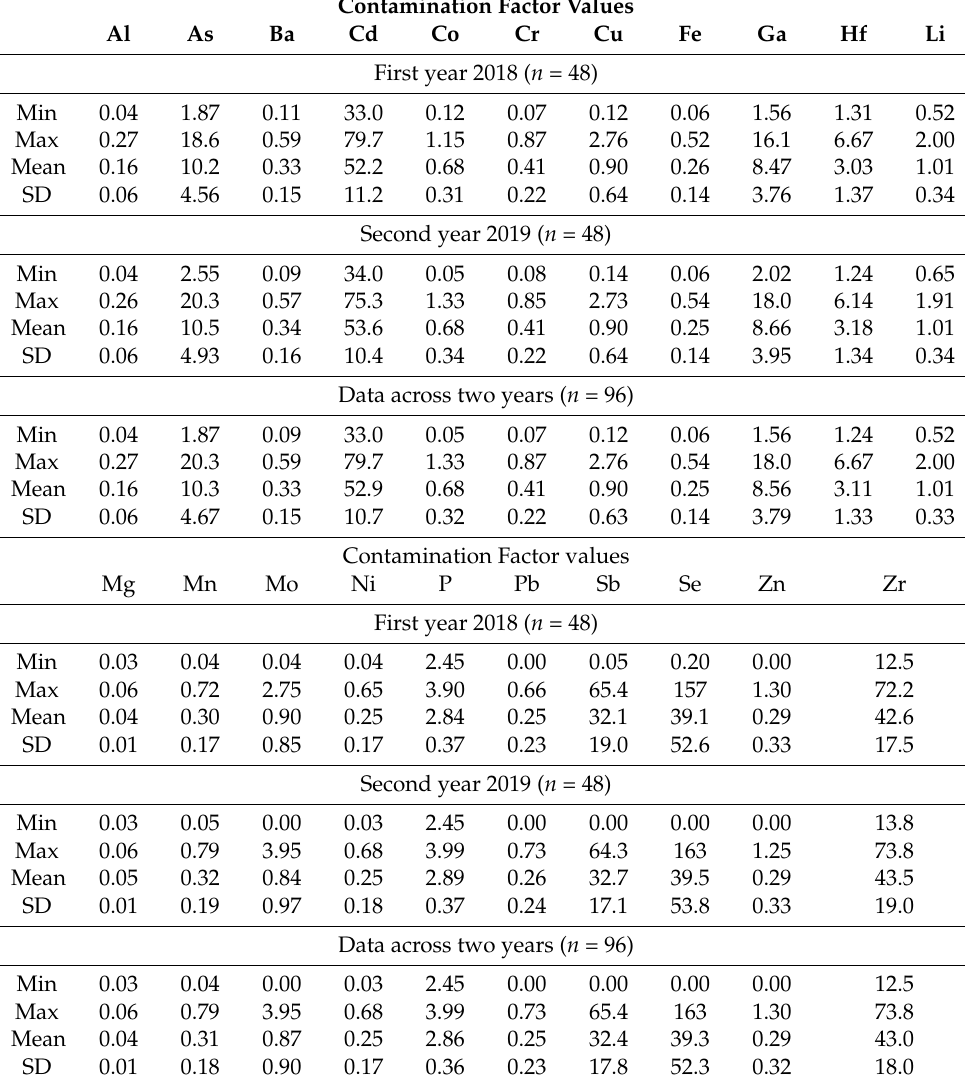
Table 3. Statistical description of contamination factors (Cf) in Qaroun Lake sediment over two